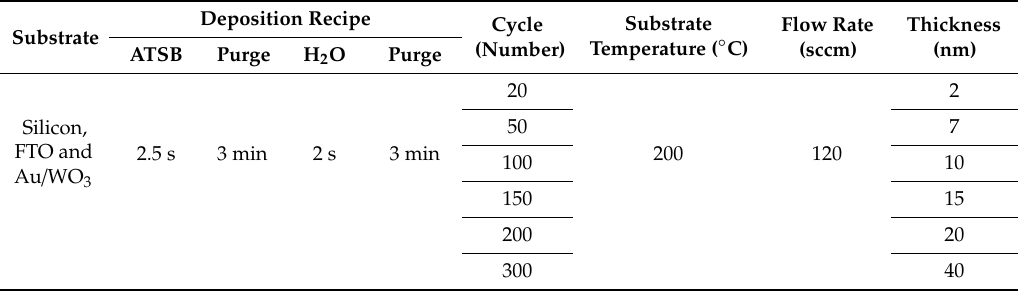
Table 1. Summary of the ALD Al 2 O 3 thin film deposition parameters and the film thickness on Au / WO 3 , FTO and silicon.